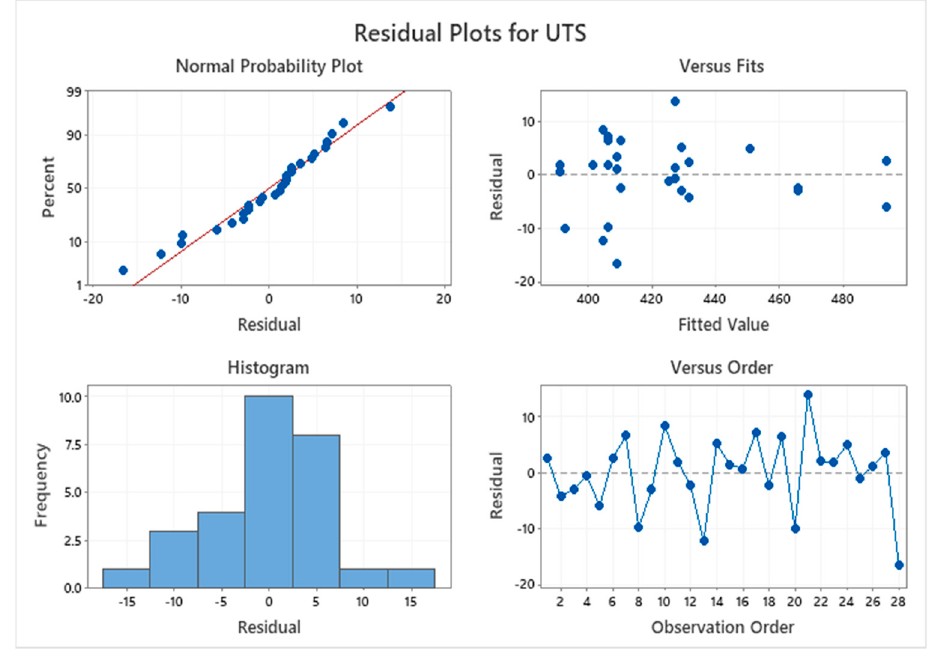
Figure 9. The residual plot for UTS.